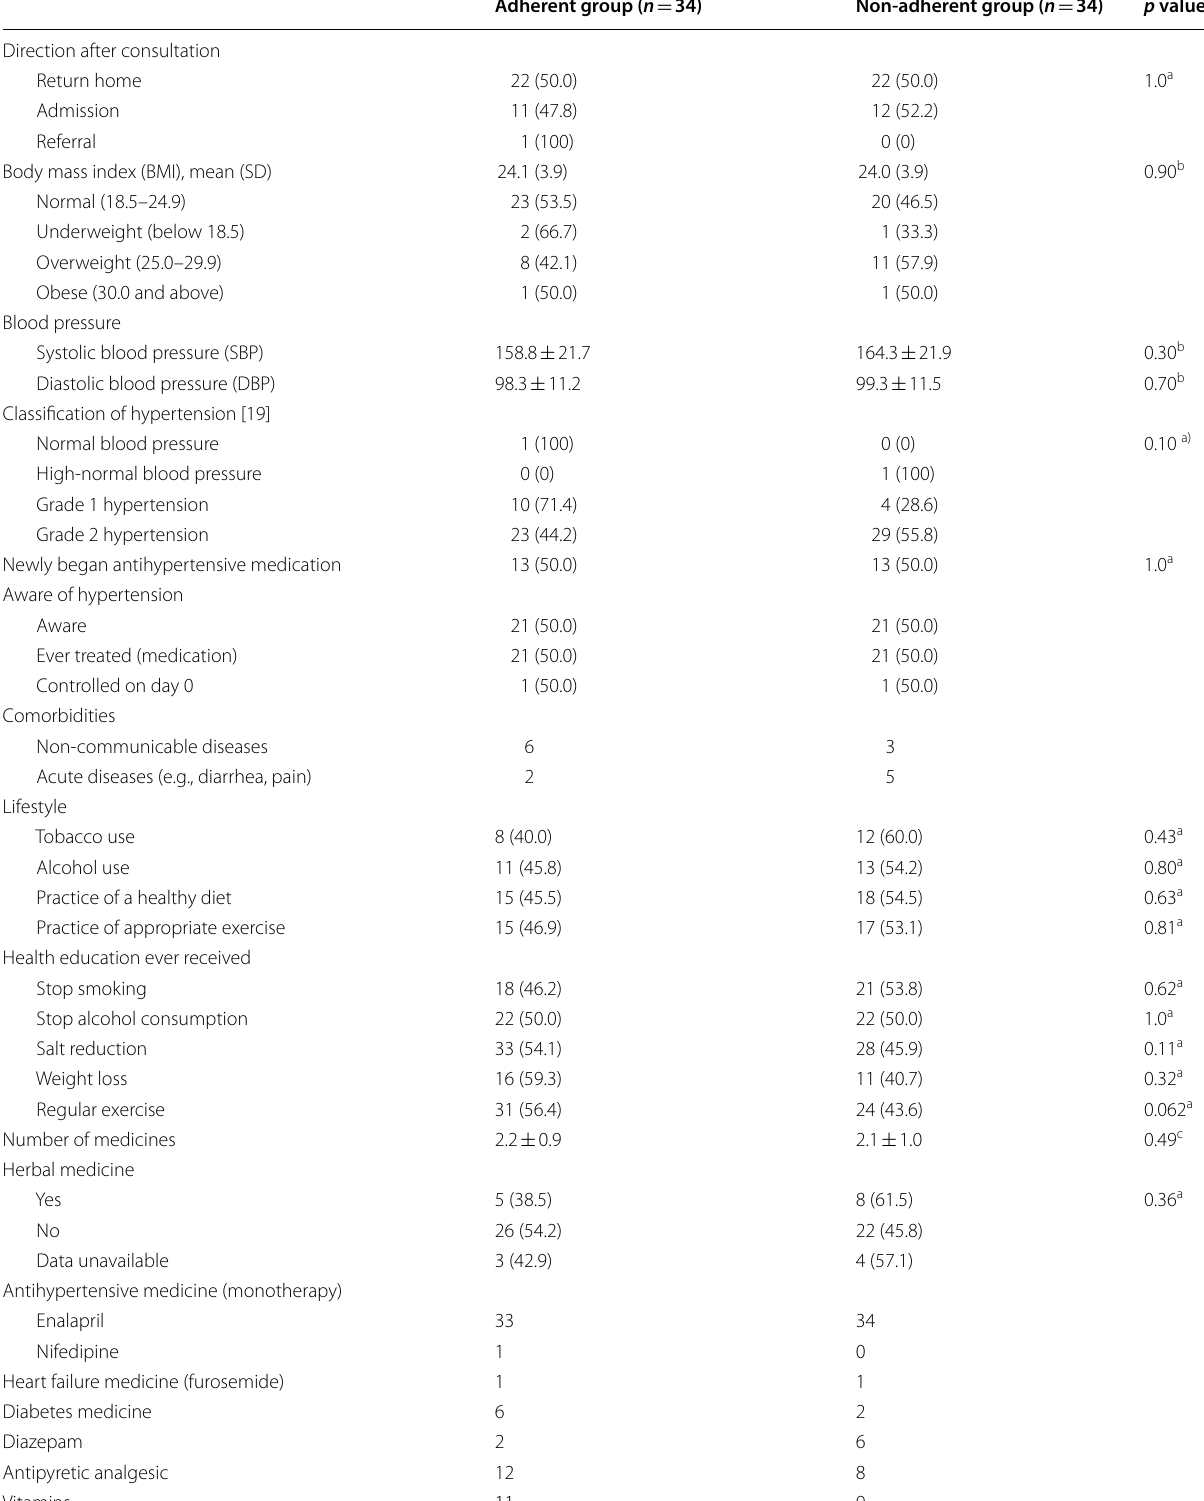
Table 3 Clinical characteristic of the patients